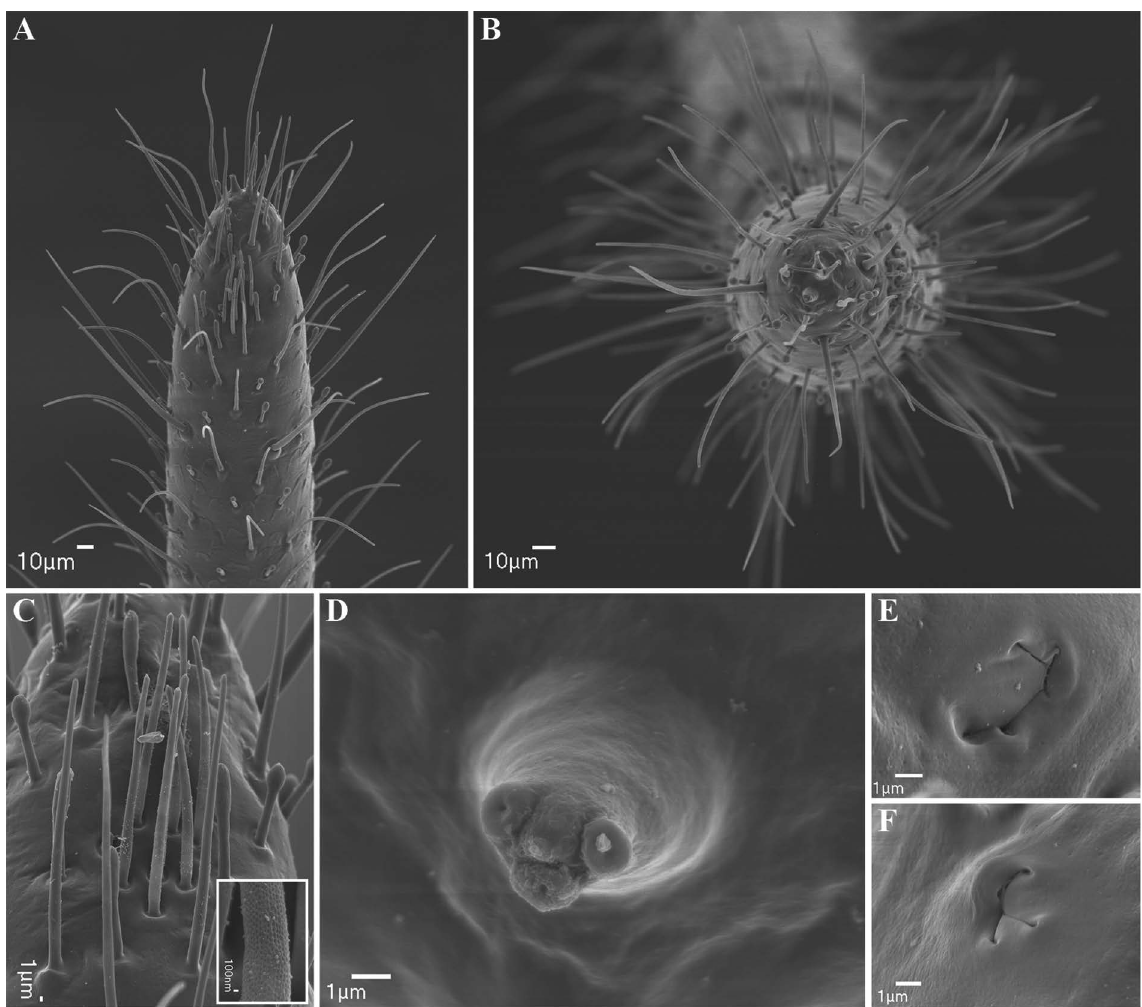
Fig. 68. Charinus imperialis sp. nov. (MNRJ 9032), leg I tarsus, ♀. A . Tarsus, apex of distal article. B . Tarsus, distal article, frontal view. C . Olfactory setae ventrally on last segment of tarsus. D . Tarsal organ near claw of tarsus. E . Slit sensilla near base of tarsal organ. F . Another slit sensilla on opposite side of